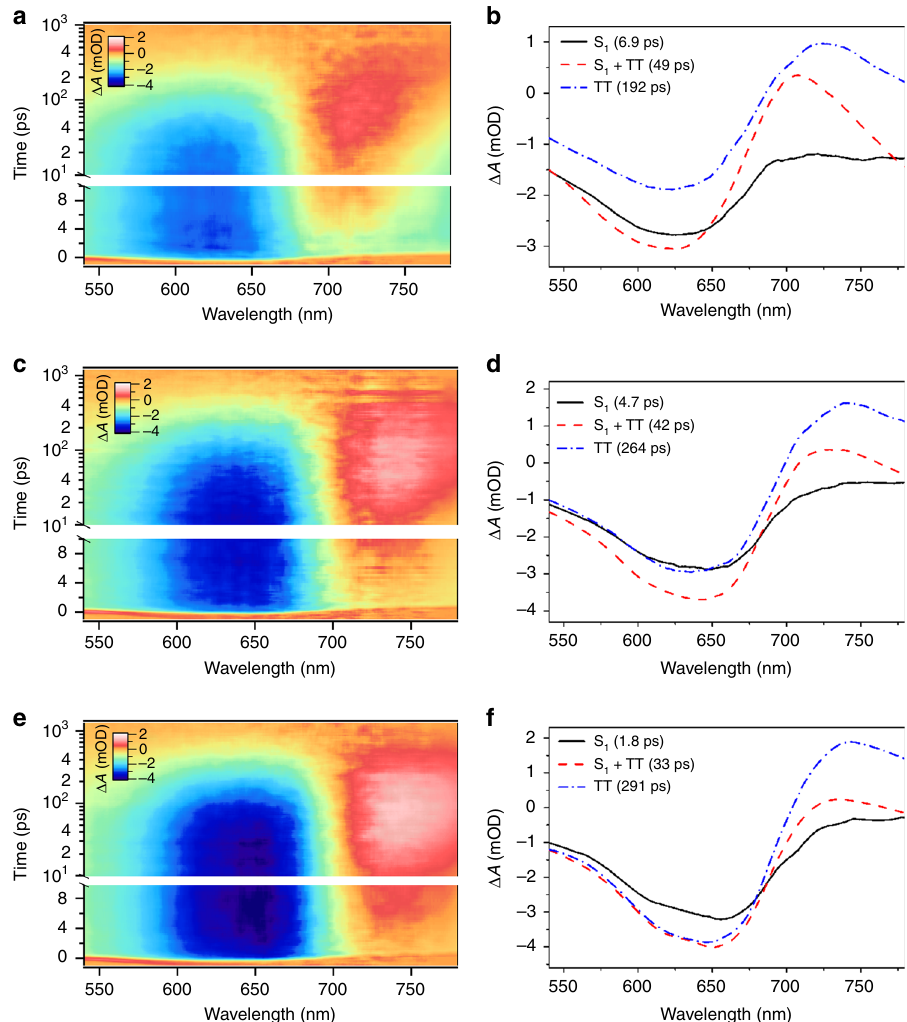
Fig. 5 Low temperature transient absorption. Transient absorption of IIDDT-Me in the CHCl 3 solution at room temperature ( a ), 270 K ( c ) and 255 K ( e ) are shown in pseudo-color plots, and the corresponding global analysis results are shown in ( b ), ( d ), and ( f ),